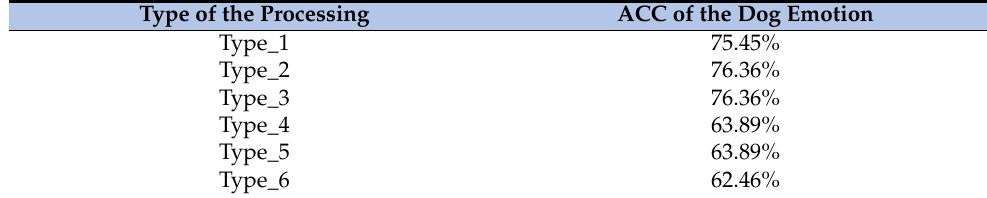
Table 17. Identi fi cation accuracy of model types in experiments conducted using IMG_0033 data- set. Table 17. Identification accuracy of model types in experiments conducted using IMG_0033 data-set.